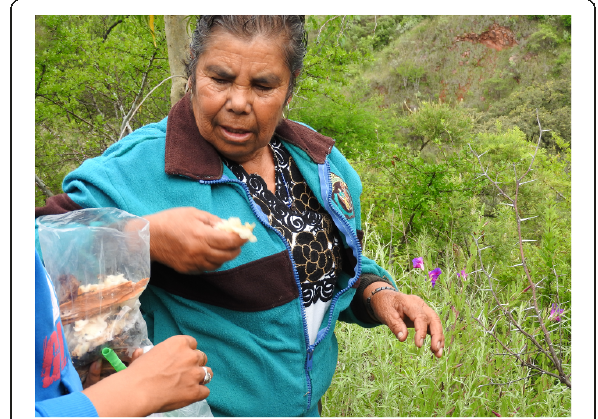
Fig. 3 Doña Caritina, mestizo woman recollecting orejas de